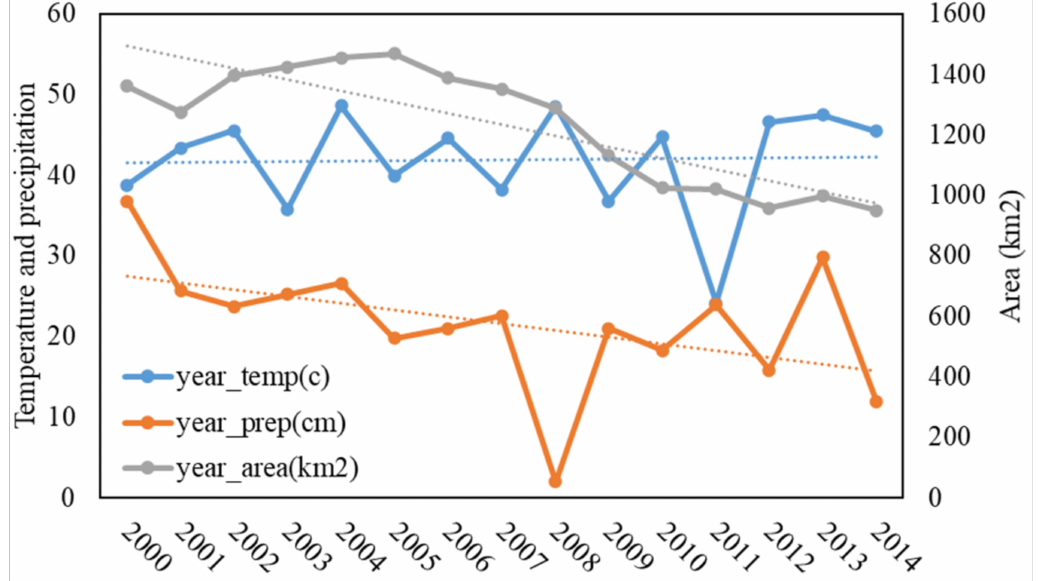
Figure 14. Comparison between yearly lake area and yearly temperature and summer precipitation from 2000 to 2014 for Tengiz Lake